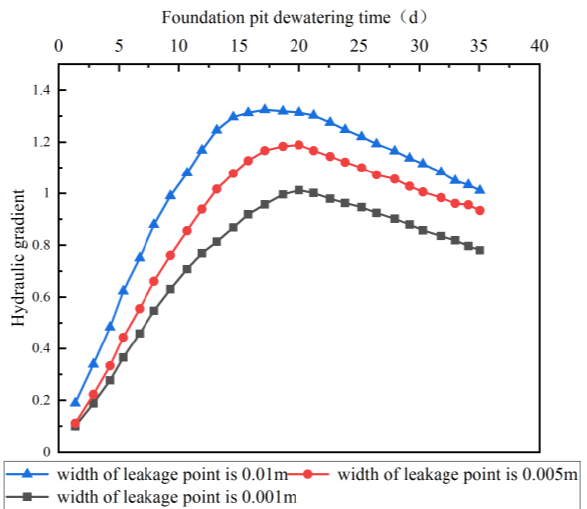
Figure 15. The curve of the hydraulic gradient with precipitation time at the leakage with different sizes.